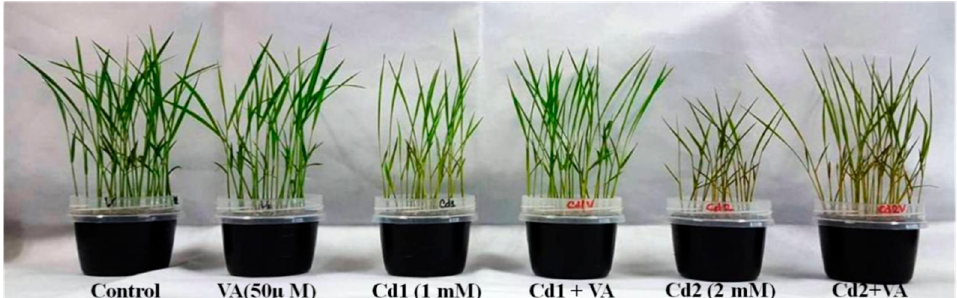
Figure 1. Visual images of the morphological differences in rice ( Oryza sativa L. cv. BRRI dhan54) seedlings grown under different treatments: VA (50 µM vanillic acid), Cd1 (1.0 mM CdCl 2 ), andCd2 (2.0 mM CdCl 2 ).